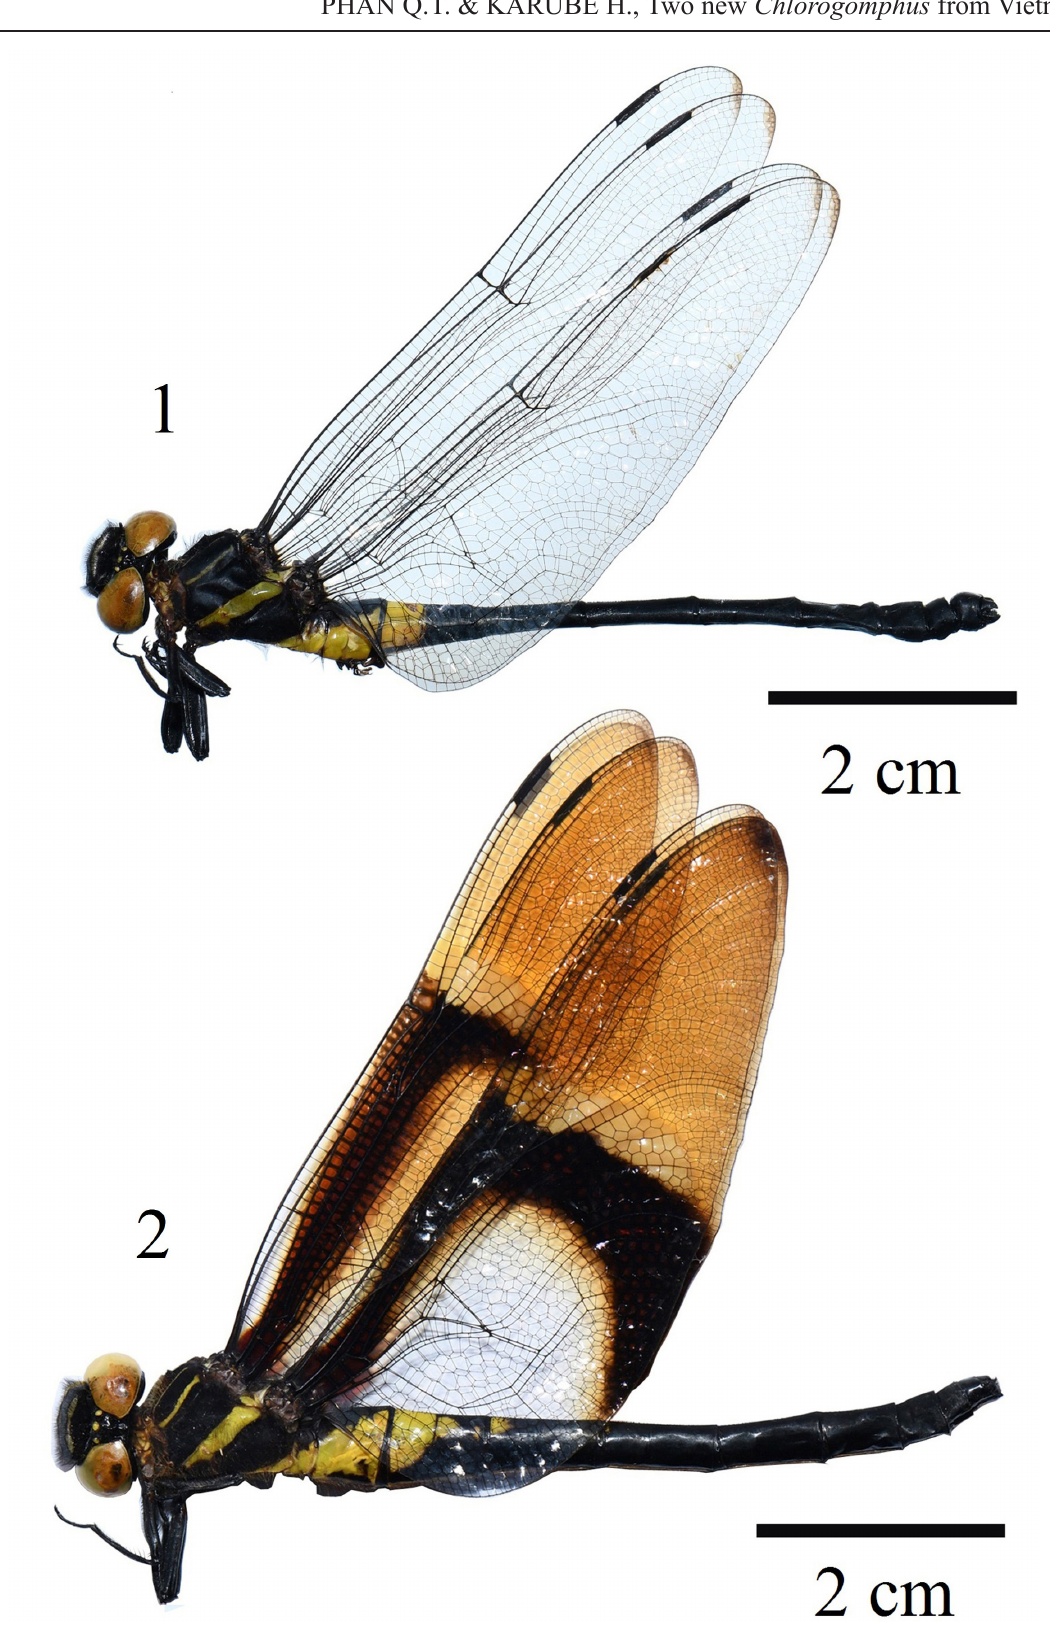
Figs 1–2. Habitus of Chlorogomphus hoaian sp. nov. 1 . Holotype, ♂ (ZCDTU 2019042001-ODO). 2 . Paratype, ♀ (ZCDTU